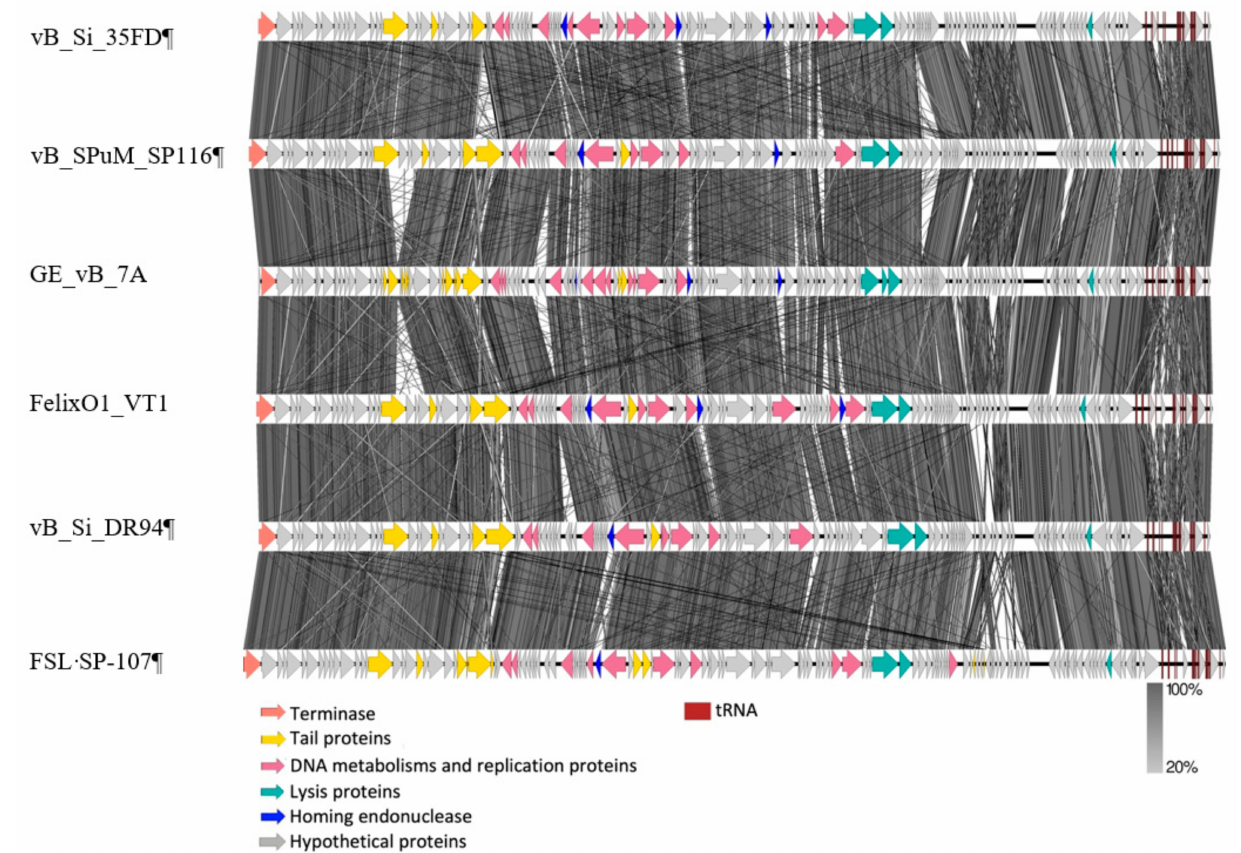
Figure 4. Aminoacidic alignment of six phages. The genes with relevance were marked with colors. All genomes start from terminase large subunits (orange), tail proteins were marked in yellow, all phages presented common components, such as tail tape measure proteins. Proteins associated with DNA metabolism and replication were marked in pink and lysis proteins in green. All phages contained two proteins associated lysis. Homing endonucleases were marked in blue and hypothetical proteins in grey. tRNAs were found at the end of all genomes (dark red